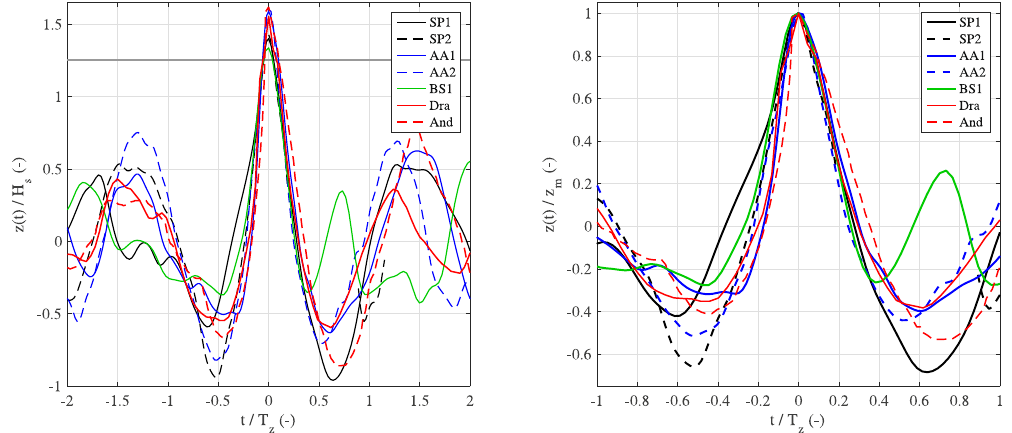
Figure 4. (left panel) Normalized (with H s and T z ) temporal profile of sea surface elevations around the observed maximum crest height ( z m ) of the ST records. Time of the maximum crest is set equal to zero for all profiles. The horizontal gray line at 1.25 represents the rogue threshold. Note that for t > 0 some data are missing in the record SP2. (right panel) Normalized (with z m and T z ) temporal profile of sea surface elevations around the observed maximum crest height ( z m ) of the ST records. Axis limits change between panels for the sake of clarity. The Draupner (Dra) and Andrea (And) rogue waves are also